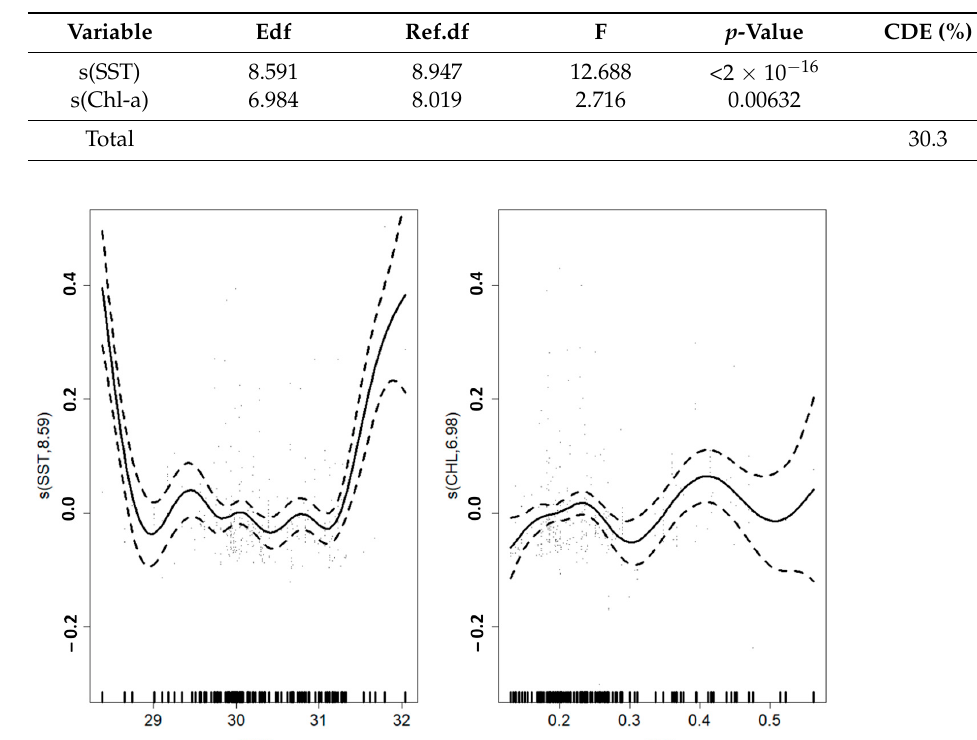
Table 2. Final GAM construction summary for the approximate significance of smooth terms.